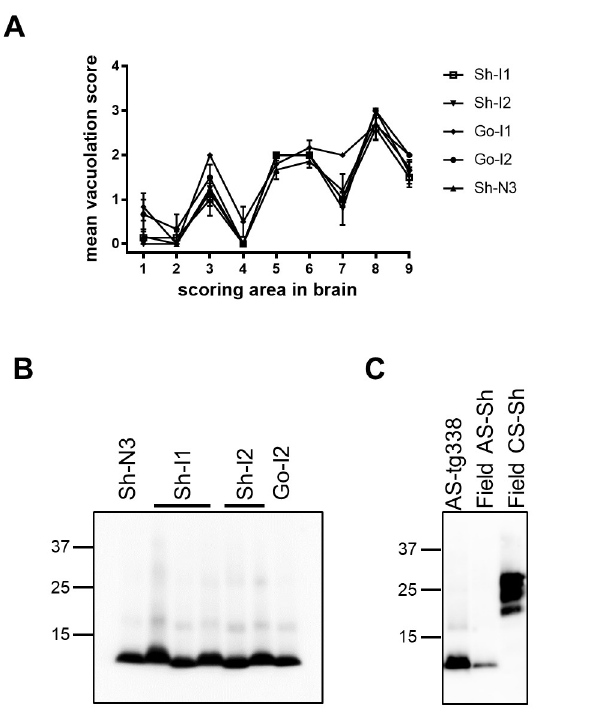
Fig 1. Distribution of spongiform neurodegeneration and PrP Sc type in tg338 mice infected with AS isolates from Italian sheep and goats. (A) Lesion profiles in groups of tg338 mice infected with AS isolates reported in Table 2. Data points represent the mean ± SEM of at least five mice per group. Brain-scoring areas: medulla [1], cerebellum [2], superior colliculus [3], hypothalamus [4], thalamus [5], hippocampus [6], septum [7], retrosplenial and adjacent motor cortex [8], and cingulate and adjacent motor cortex [9]. (B) Representative western blot showing PK-treated PrP Sc from brains of tg338 mice inoculated with the AS isolates (indicated on the top of the blot). The AS inocula are indicated as in Table 2. The positions of MW markers are indicated on the left of the blot (in kilodaltons). Membrane was probed with 9A2 monoclonal antibody. (C) Representative western blot showing PK-treated PrP Sc from brains of tg338 mice inoculated with AS in comparison with sheep naturally infected with AS or CS (indicated on the top of the blot). The positions of MW markers are indicated on the left of the blot (in kilodaltons). Membrane was probed with 9A2 monoclonal